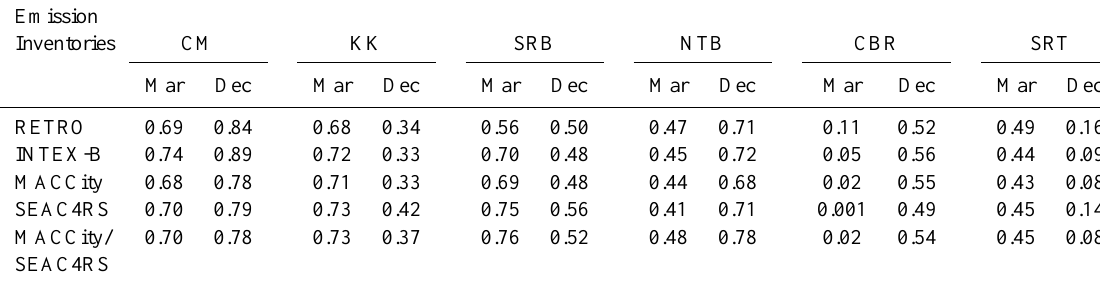
Table 6. Monthly-average biases of daytime (00:00, 06:00, 12:00UTC) O 3 . Emission